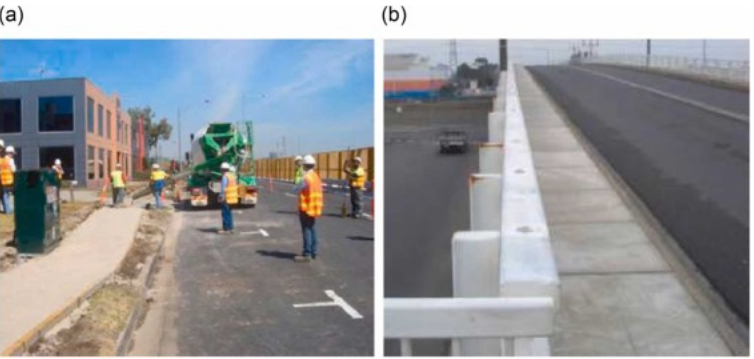
Figure 5. ( a ) Westgate Freeway paving in Port Melbourne and ( b ) E-Create Precast Panels. Re- printed/adapted with permission from [122]. 2012. Van